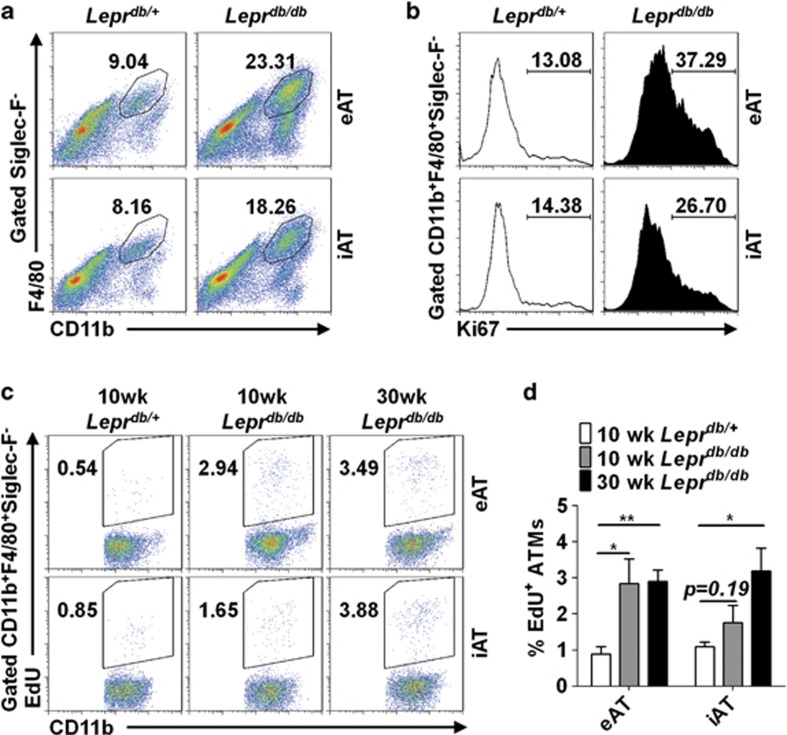
Proliferation of ATMs at the early stage of genetic obesity. (a) Flow cytometric analysis of ATM accumulation in eAT and iAT from 7-week-old leptin receptor-deficient mice (Leprdb/db) and their heterozygous littermates (Leprdb/+). Representative dot plots are shown. Numbers on the graphs indicate the percentage of gated events in total events recorded. (b) Flow cytometric analysis of Ki67 expression in ATMs from eAT and iAT of 7-week-old leptin receptor-deficient mice (Leprdb/db) and heterozygous littermates (Leprdb/+). (c) Flow cytometric analysis of EdU incorporation in ATMs from eAT and iAT of Leprdb/db mice and their heterozygous siblings. (d) Summarizing of the data in panel (c) are shown as means±S.E.M. n=3–4 mice in each group, *P<0.05, **P<0.01